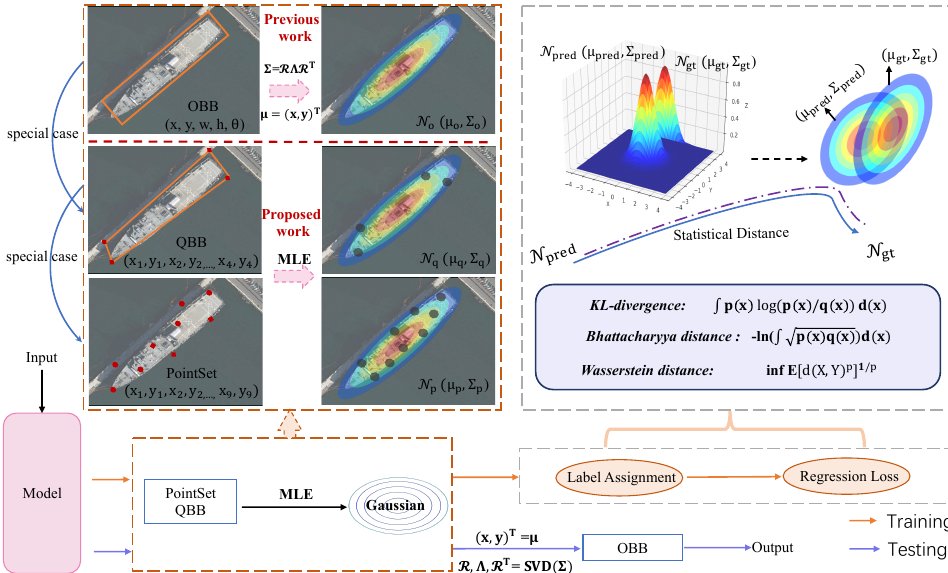
Figure 2. Overview of the main contributions of this paper. Gaussian distributions of QBB and PointSet are constructed, and label assignment strategies and regression losses are designed in an alignment manner based on statistical